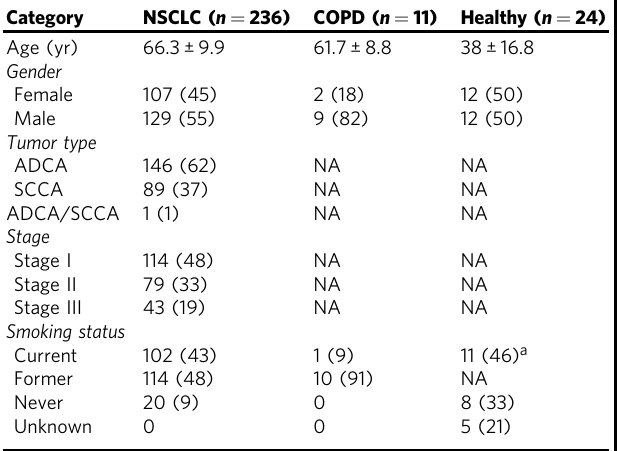
Table 1 Clinicopathologic features of studied